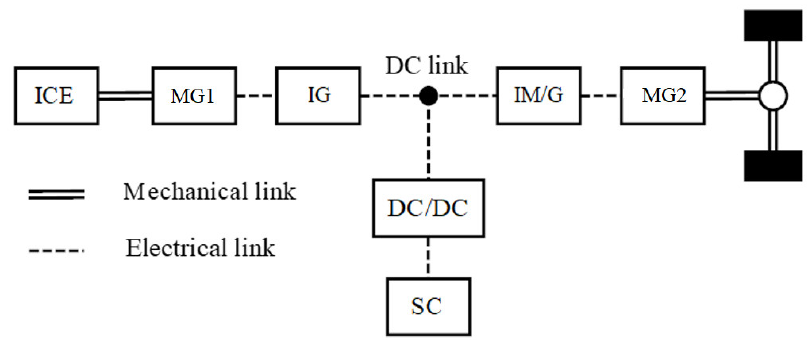
Figure 9. Series architecture scheme.